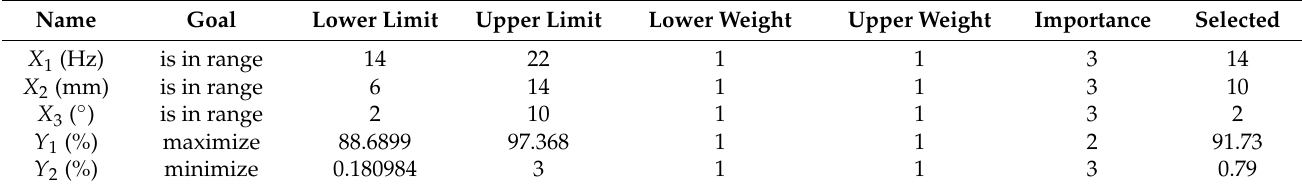
Figure 12. The response surface for the effect of the interaction of the factors on the screening efficiency. ( a ) Response surface of the effect of SA and IA on loss rate; ( b ) Response surface of the effect of VF and IA on loss rate; ( c ) Response surface of the effect of VF and SA on loss rate. Table 5. Optimization of multiple parameters.